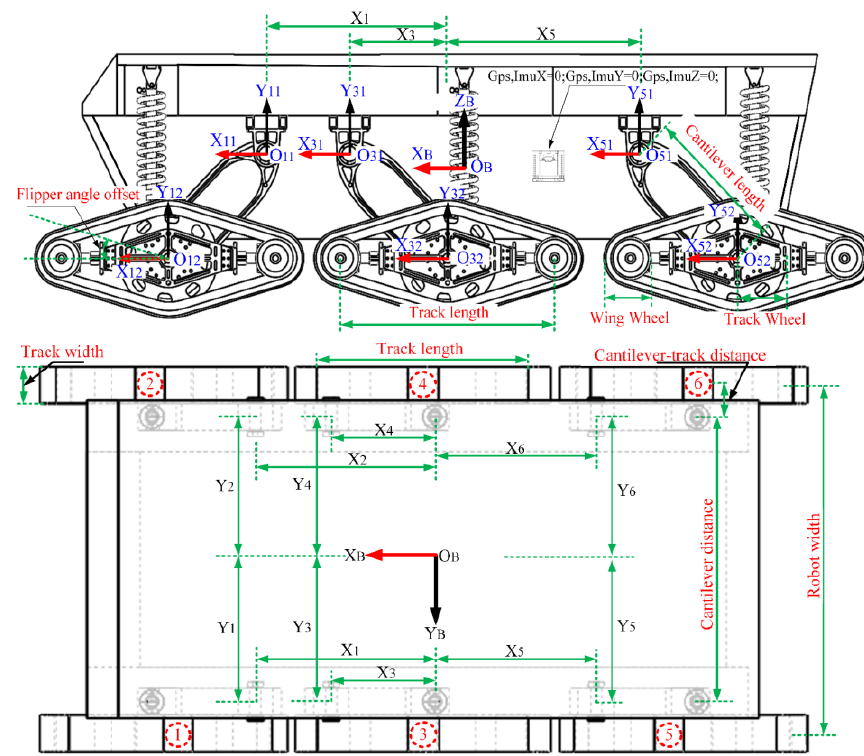
Figure 1. Mechanical structure of the six-track robot. Table 1. Nominal parameters of six-track robot.